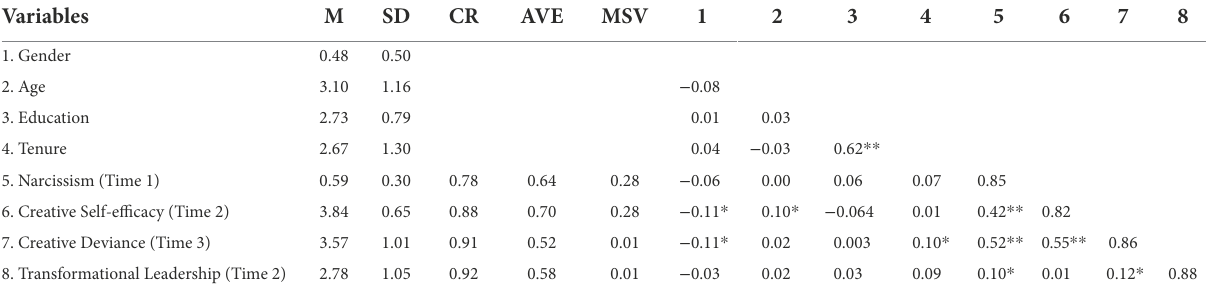
TABLE 3 Moderated mediation